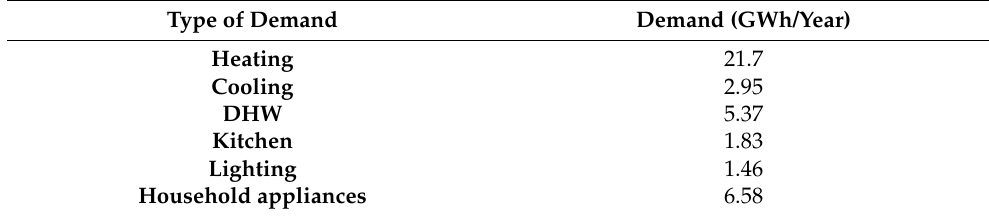
Table 4. Annual energy